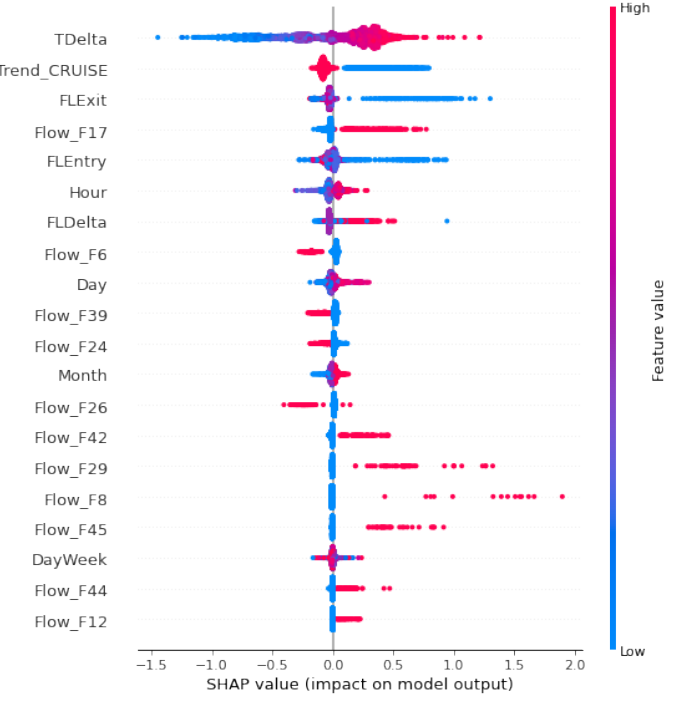
Figure 8. SHAP values of the regression model for Sector 1.